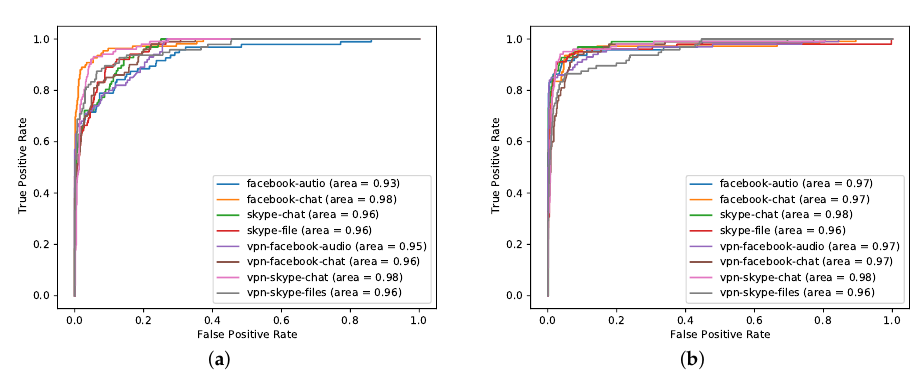
Figure 6. ROC curve of eight-layer BERT (best) at 40% sample size. The picture on the left ( a ) is the model without pre-training, and the picture on the right ( b ) is the model with pre-training. The abscissa is the FPR, and the ordinate is the TPR. The eight colors represent the eight classes of data in the downstream tasks.